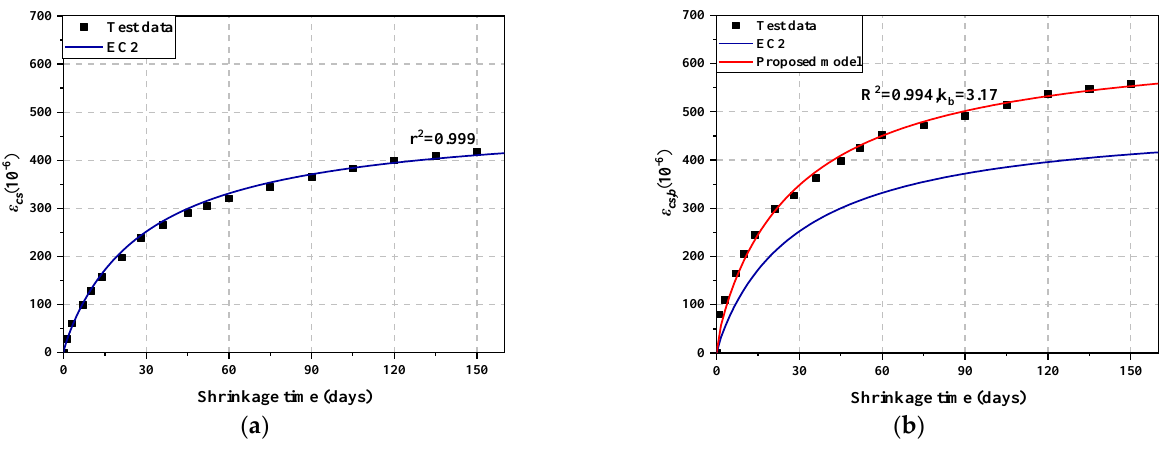
Figure 11. Predicted and tested values of ( a ) NAC and ( b ) TIC.